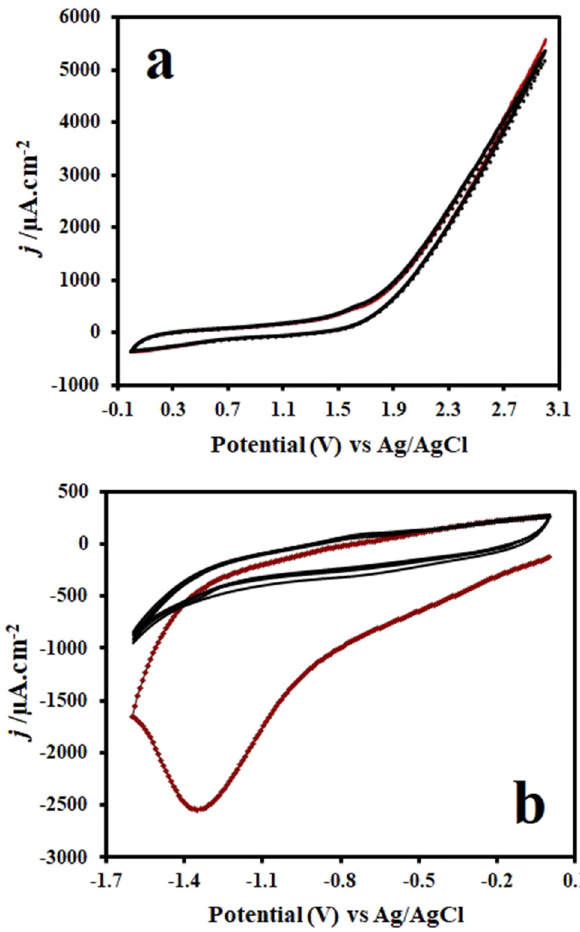
Figure 1: ( a ) CV curves of GONs production on graphite electrode for four successive sweeps in PBS ( pH 6.5 ) at a scan rate of 50 mV/s and ( b ) cyclic voltammograms of the GON - modi fi ed graphite elec - trode were recorded for fi ve consecutive sweeps to synthesize rGONs in PBS ( pH 6.9 ) at a scan rate of 50